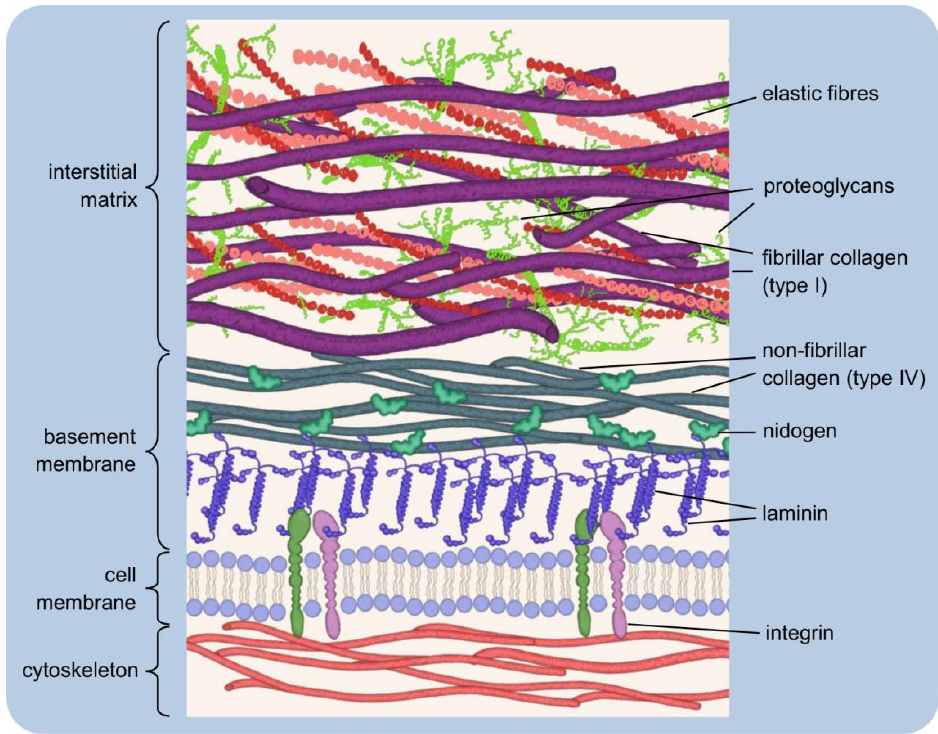
Figure 1. Simplified extracellular matrix structure: three-dimensional macromolecular network composed of various proteins and polysaccharides. The pericellular matrix forms a layer adjacent to the cells: integrins bind to polymerised laminin, which, in turn, is connected via nidogen to the type IV collagen. Interstitial matrix forms porous network of fibrillar collagens, elastic fibres, and proteoglycans.